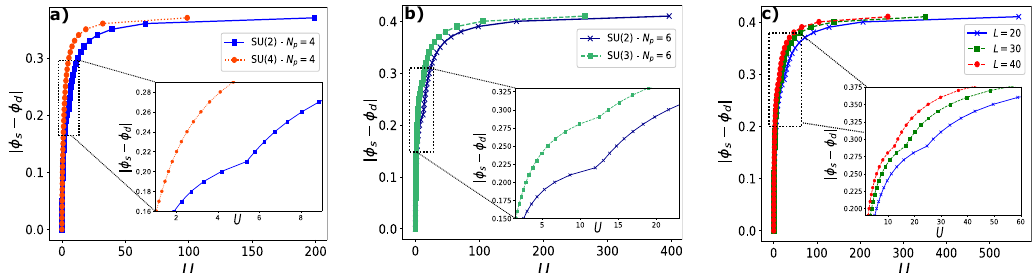
Figure 9: Comparison of spinon creation in SU(2) fermions and SU( N ) fermions. − φ | against interaction U is considered for a a) Spinon creation flux distance | φ s d = 4 fermions with N = 2 and N = 4 spin components, ring of L = 40 sites with N p where φ is the flux at which spinons are created and φ is the degeneracy point. s d The intermediate U regime (inset) highlights the discontinuity present in the SU(2) case. b) Spinon creation flux distance against interaction for a ring of L = 40 sites = 6 fermions with N = 2 and N = 3 spin components. The inset depicts the with N p disconituities for intermediate U in both systems. c) Spinon creation is for a system = 6 particles with N = 3 with various system sizes, L = 20, L = 30 and with N p L = 40. All the presented results are obtained with Bethe ansatz of the Gaudin-Yang- Sutherland model.